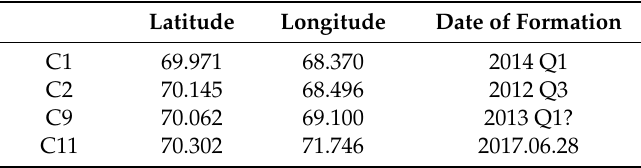
Table 1. Coordinates of the gas blowout craters on the Yamal Peninsula. Latitude Longitude Date of